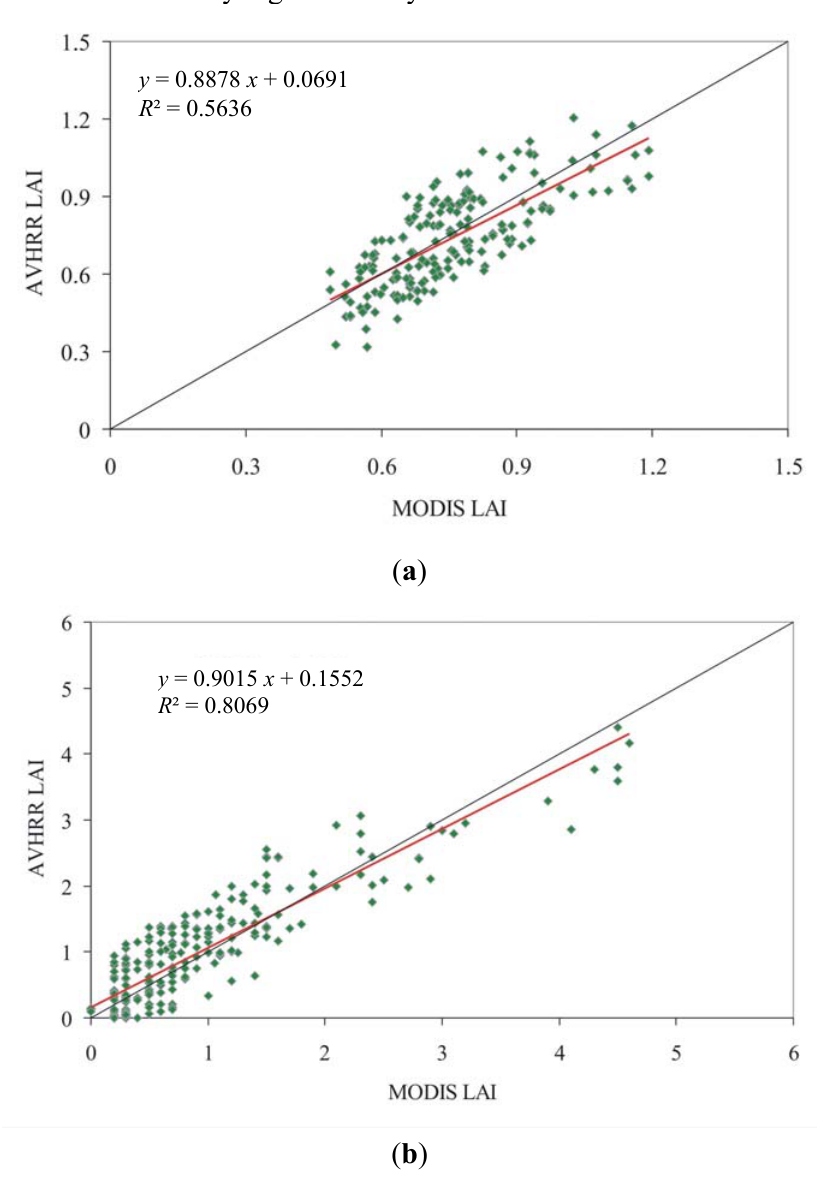
Figure 9. Comparison of the AVHRR LAI and MODIS LAI product. ( a ) LAI estimates over the grassland test area in Shetsky raion for June 2008. ( b ) LAI estimates over the wood/forest test area in Almaty region for July 2008. y = 0.8878 x +